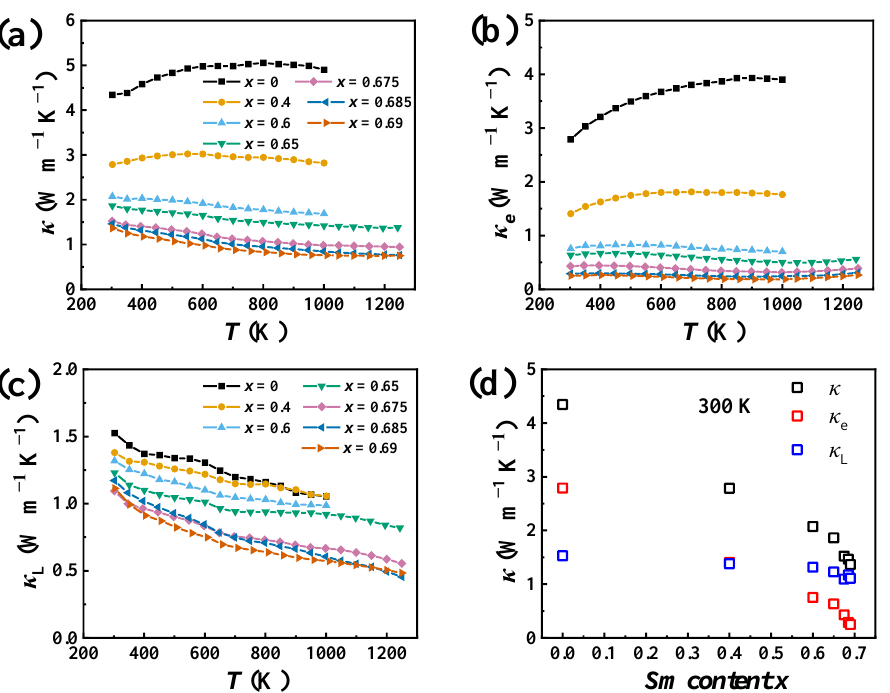
Figure 3. Temperature dependence of ( a ) total thermal conductivity κ total , ( b ) electric thermal conductivity κ e , and ( c ) lattice thermal conductivity κ L for La 3 − x Sm x Te 4 ( x = 0, 0.4, 0.6, 0.65, 0.675, 0.685, 0.69)/10 vol.% Ni composites. ( d ) Room temperature κ total , κ e , and κ L as a function of the Sm content for all samples.